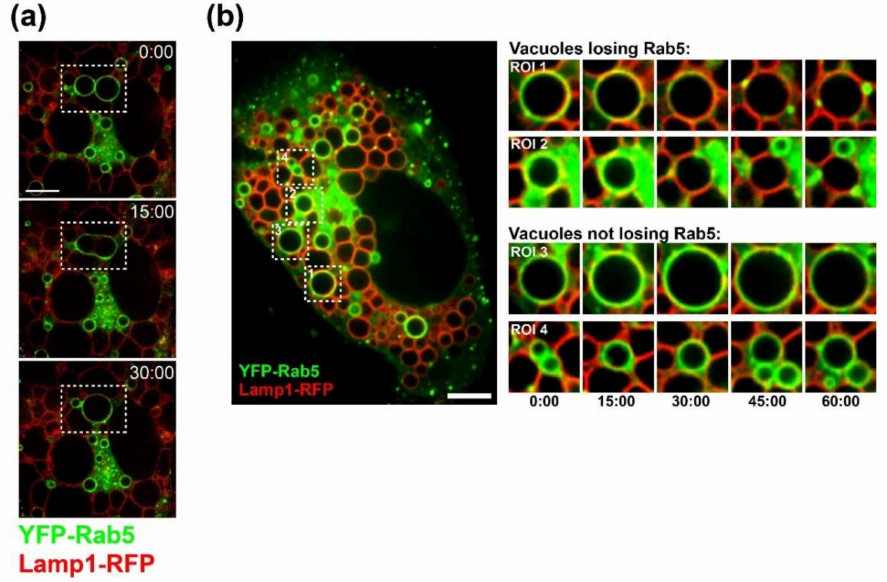
Figure 2. Dynamic vacuole formation: ( a ) image sequence (top to bottom) from a time-lapse movie (Movie S1) showing fusion of YFP-Rab5-positive vacuoles in an SV40-infected CV-1 cell. Lamp1-RFP is shown in red. The boxes outline two YFP-Rab5 vacuoles that fuse. Numbers in this and panel B show time in minutes. Scale bar, 5 µ m; ( b ) Overview image and time series of four regions of interest (ROI 1 to 4) from time-lapse movie S2 showing YFP-Rab5 (green) dynamics on SV40-induced vacuoles (Movie S2): ROIs 1 and 2 show vacuoles that lose YFP-Rab5 fluorescence, and ROIs 3 and 4 show vacuoles with stable YFP-Rab5 fluorescence. Lamp1-RFP is shown in red. Scale bar, 10 µ m.